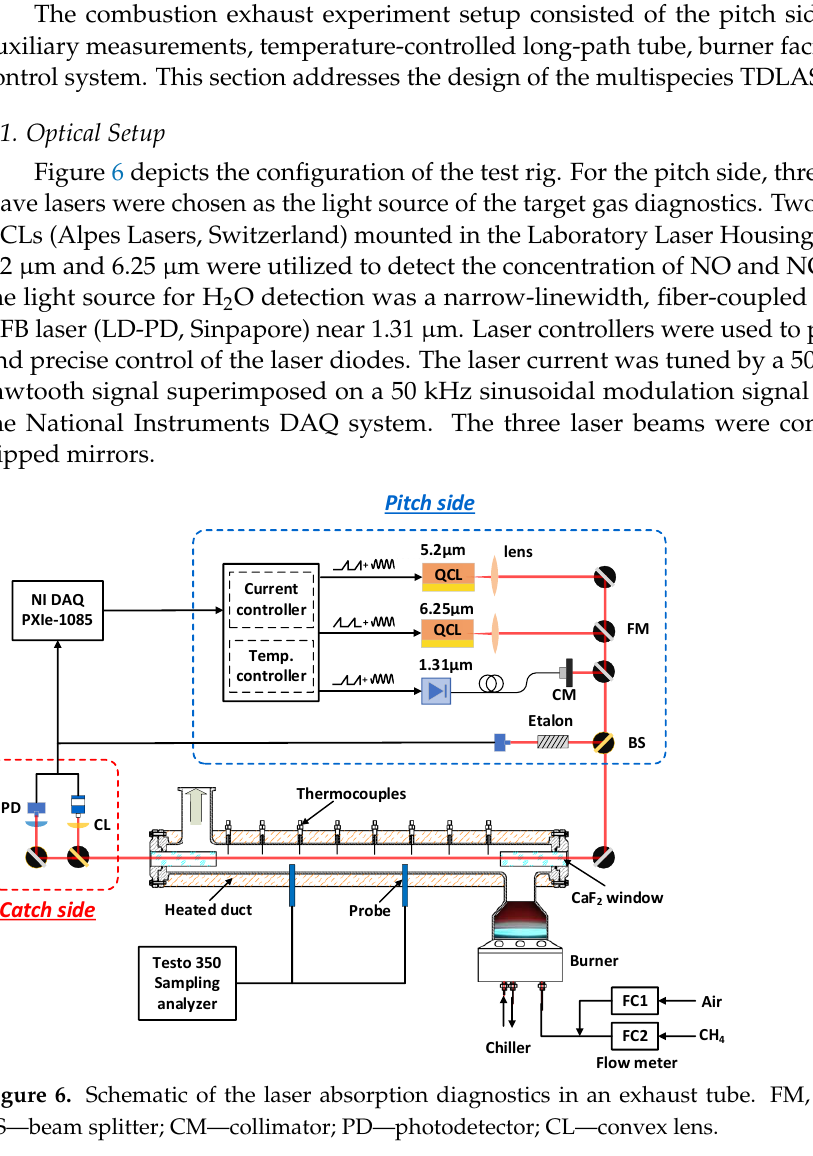
Figure 6. Schematic of the laser absorption diagnostics in an exhaust tube. FM, flipper mirror; BS—beam splitter; CM—collimator; PD—photodetector; CL—convex lens. For the catch side, the transmitted laser beam was split into two parts by a CaF 2 beam splitter. Then, these two parts were separately focused on an HgCdTe thermo-electrically cooled MIR detector LabM-I-6 (Vigo, Poland) and an InGaAs amplified NIR photodetec- tor PDA10CS2 (Thorlabs, United States). The absorption signals were recorded by the DAQ system at a sampling rate of 2 MHz. The relationship between the laser scanning time and frequency can be characterized by a silicon etalon placed in another laser path. 3.2. Exhaust Tube Hardware The cylindrical exhaust tube provided a 157.5 cm effective optical length, with 25 cm CaF 2 column windows at both ends of the combustion tube to reduce the influence of the non-uniform temperature. Moreover, thermal insulation of the exhaust tube was provided by wrapping it in heating cables and ceramic wool. During the experiment, a McKenna burner provided combustion emissions with a relatively stable composition. The gas flow rates of the fuel and air were controlled and monitored by two mass flow controllers (Bronkhorst, 1% accuracy). The air flow rate was maintained consistently, and the exper- imental conditions were changed by adjusting the fuel flow rate. The equivalence ratio of the premixed CH 4 /air flat flame varied from 0.73 to 0.99, as shown in Table 1. Additionally, a cylinder glass cover was placed around the plate flame to prevent influence from the surroundings. Table 1. Experimental conditions of the premixed CH 4 /air flame in this work. Flame No.